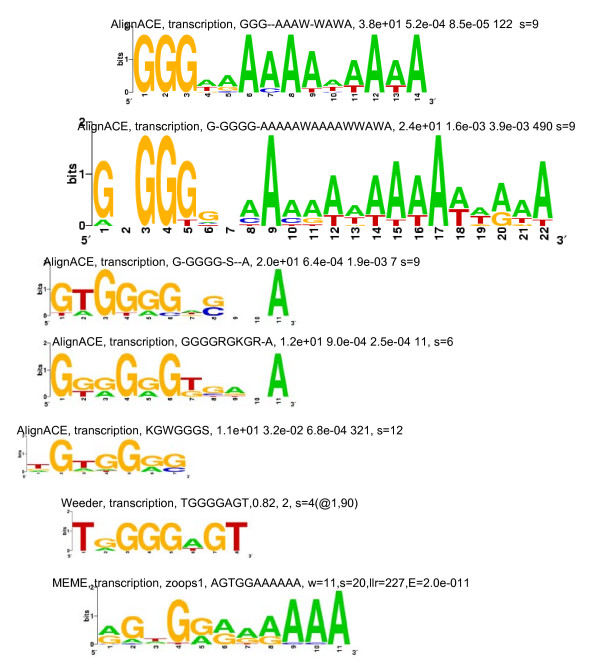
Sequence logos for the G-rich motif-sets given in Table 2 and identified in the upstream regions of the set of 22 transcription machinery genes. The logos have been manually aligned so that equivalent nucleotide positions, in the motif-sets used to generate them, lie approximately one below the other. The caption for each logo indicates the program that identified the motif-set, the group of genes whose upstream regions are being considered, the consensus motif for the motif-set and information about the motif-set output by the program. For the AlignACE logos, the caption gives the MAP (maximum a priori log likelihood [25]), group specificity and positional specificity scores, the preferred position at which the motifs occur and the number of motif occurrences in the set of upstream regions. For the Weeder logo, the caption gives a significance score, the number of 'redundant' consensus motifs related to the given one and the number of motif occurrences in the set of upstream regions when 1 mutation and a match percentage ≥ 90% are allowed. For the MEME logo, the caption gives the mode in which the program has been run, the width of the motif, the number of motif occurrences or sites in the set of upstream regions, the log likelihood ratio and the expectation value. Similar information is provided for the logos in Figures 2, 3 and 4.